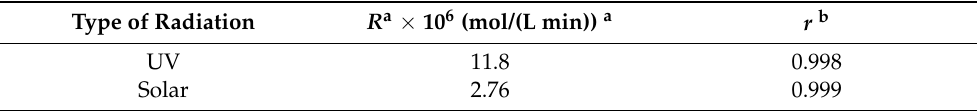
Figure 3. Effect of radiation type on the kinetics of AMI (0.0300 mmol/L) photocatalytic degradation in the presence of ZnO (1.0 mg/mL). Table 3. Effect of radiation type on AMI degradation rate (0.0300 mmol/L) in the presence of ZnO (1.0 mg/mL).